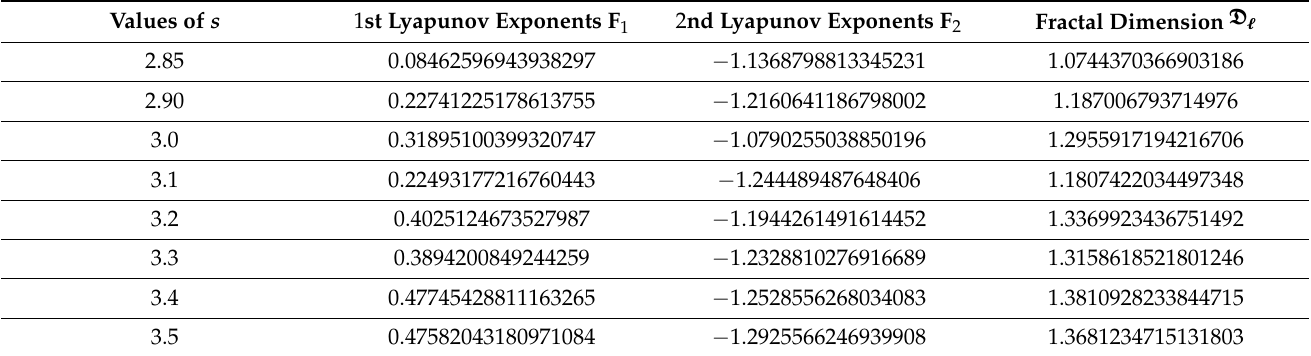
Table 1. Fractal dimension of model (4).